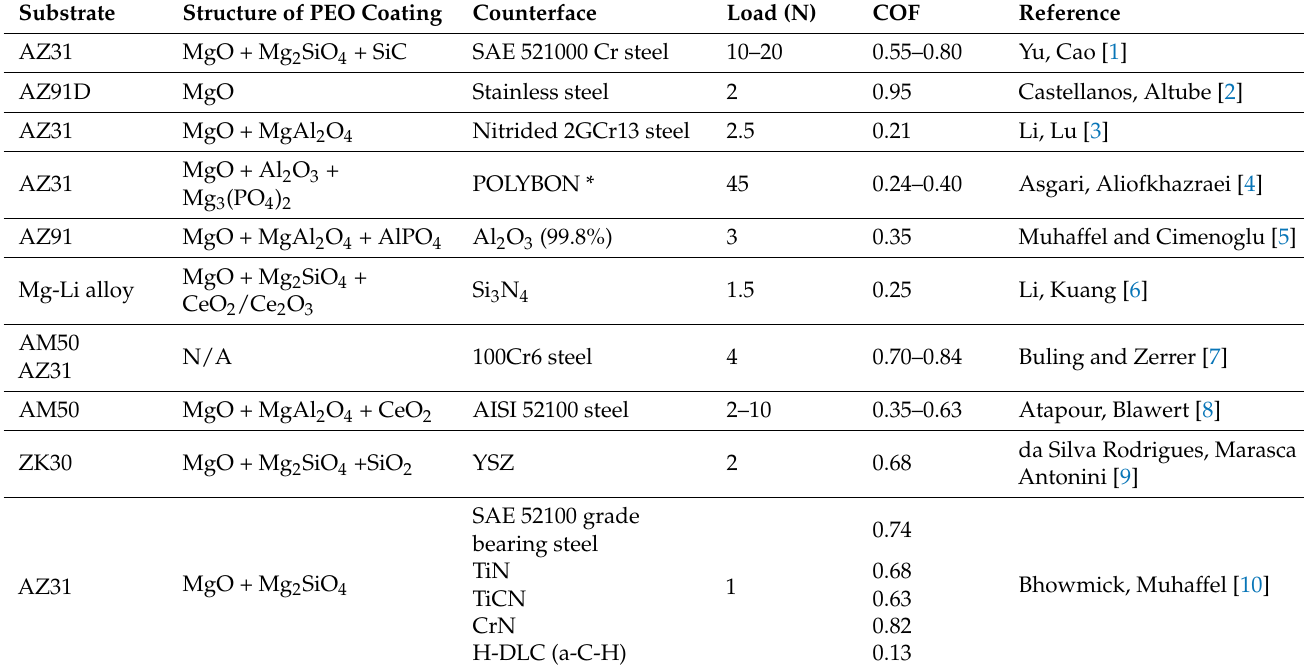
Table 1. Recently reported (since 2015) COF values of magnesium-oxide-based PEO coatings against various counterfaces under dry sliding tests conducted at room